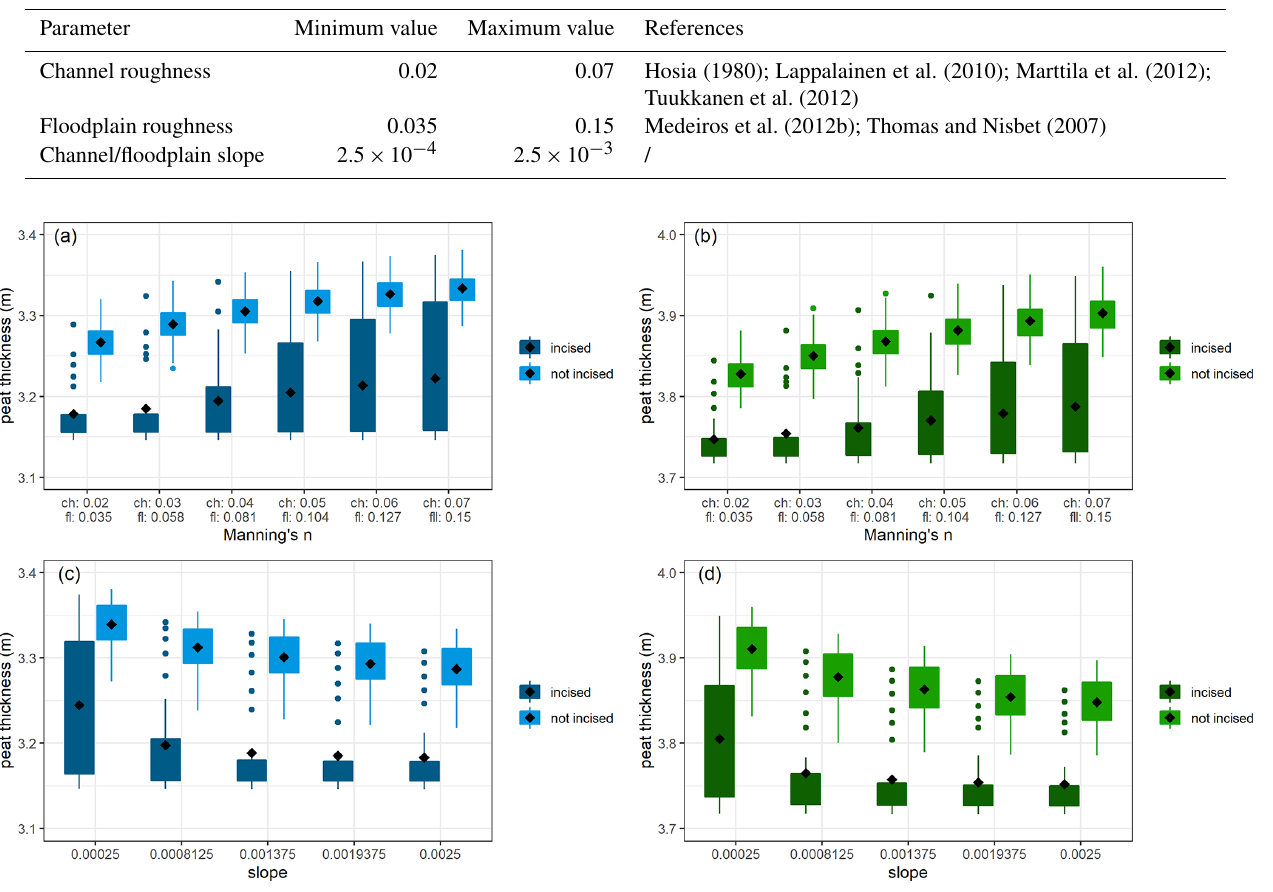
Table 2. Range over which the channel and floodplain roughness (sm − 1 / 3 ) and the channel/floodplain slope (mm − 1 ) are varied in the scenario analysis.